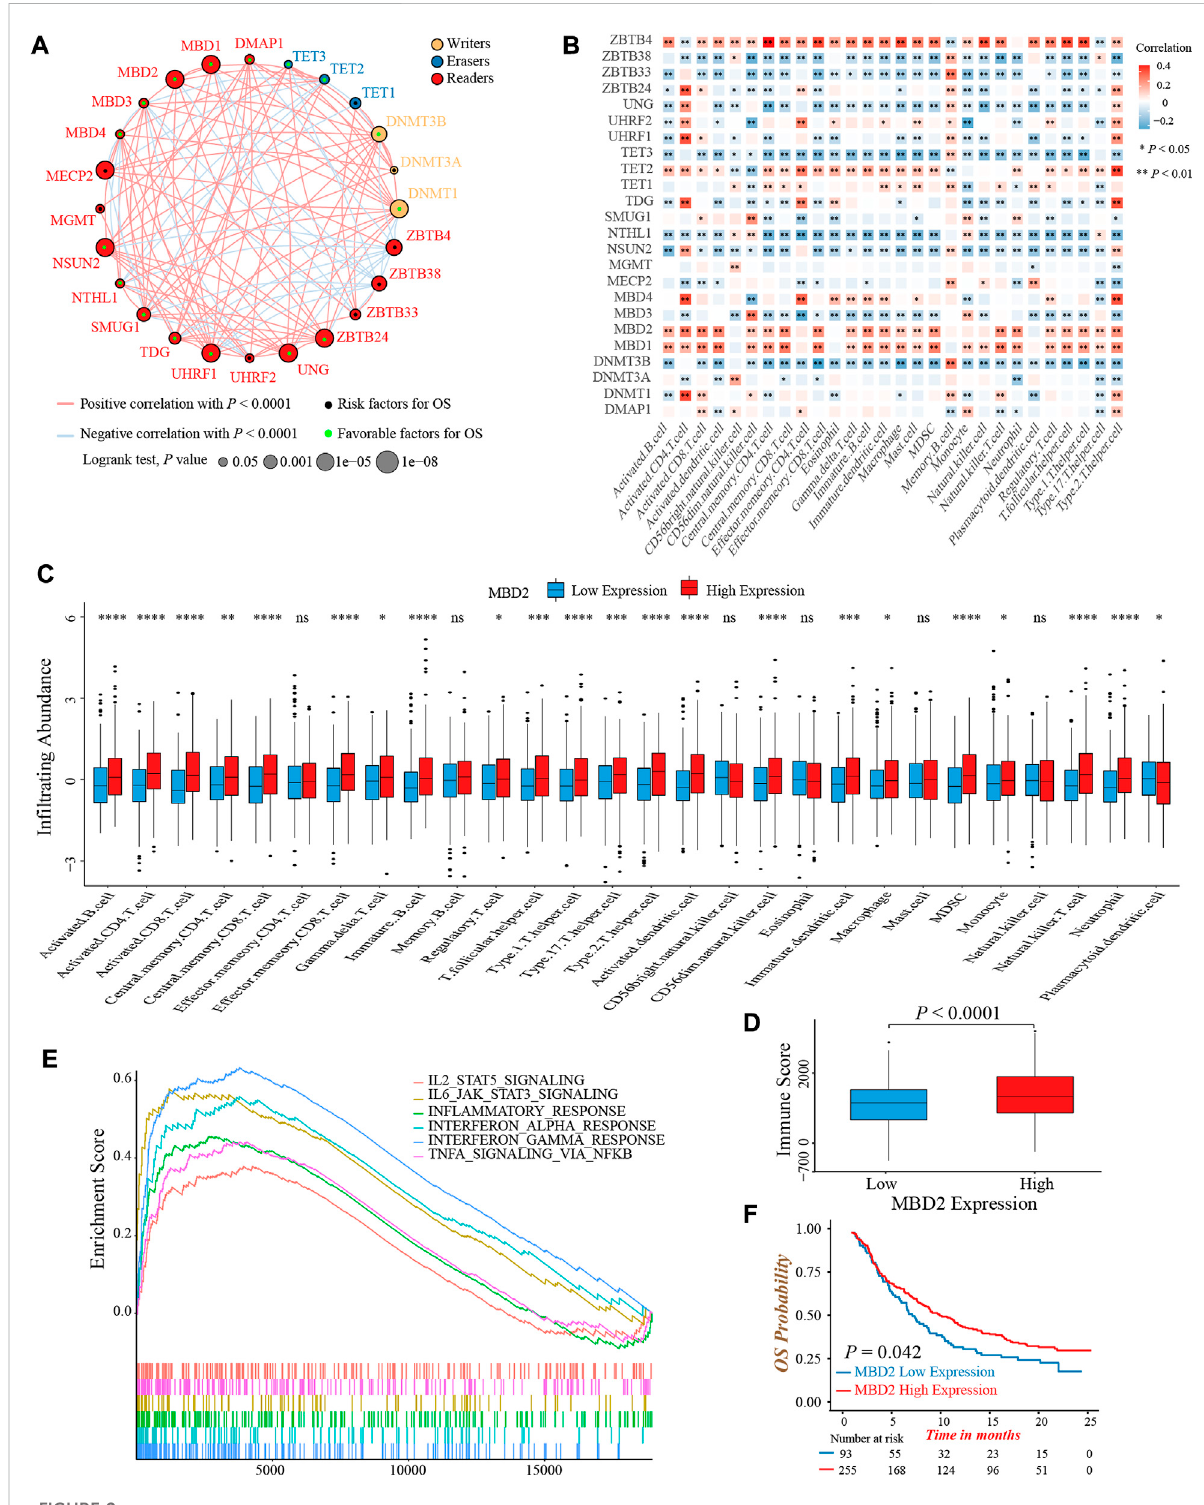
Prognosis and immune characteristics of 24 DNA methylation regulators in colon cancer. (A) The prognosis and correlation among 24 DNA methylation regulators in colon cancer (Log-rank test and Spearman correlation analysis). (B) The correlation between 28 TME in fi ltrating cell types and 24 DNAmethylation regulators (Spearman correlation analysis). (C) The in fi ltrating abundance of 28 TME cell typesbetween theMBD2 high and lowexpressiongroups(Wilcoxontest;ns:nosigni fi cance;* p < 0.05;** p < 0.01;*** p < 0.001;**** p < 0.0001). (D) Comparisonofimmunescore between the MBD2 high and low expression groups. (Wilcoxon test; p < 0.0001). (E) GSEA analysis indicated six activated immune/in fl ammation- related pathways that were enriched in the MBD2 high expression group (All p < 0.05). (F) Overall survival analysis of high and low MBD2 expression groups in the IMvigor210 cohort (Log-rank test, p =